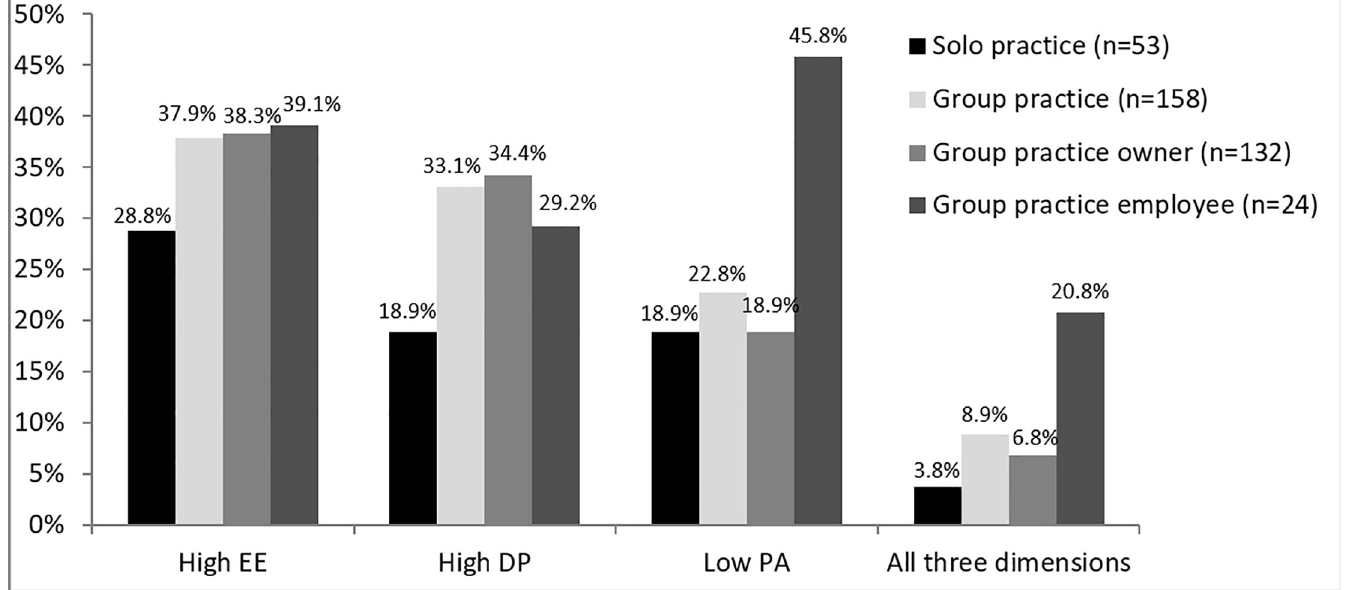
Fig 1. Burnout prevalence among general practitioners (n = 214) stratified by solo and group practices. Group practices (n = 158) were additionally stratified by working status (practice owner vs. practice employee); emotional exhaustion (EE), depersonalization (DP) and personal accomplishment (PA).